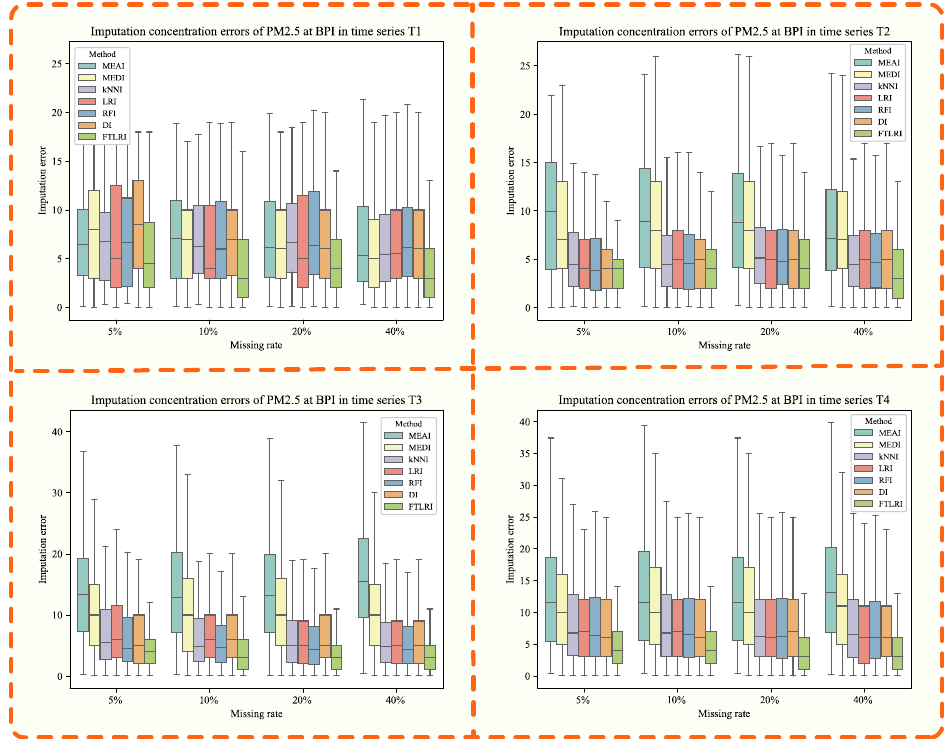
Figure 9. Imputation concentration errors of PM 2.5 generated by MEAI, MEDI, kNNI, LRI, RFI, DI, FTLRI at BPI in different time series.